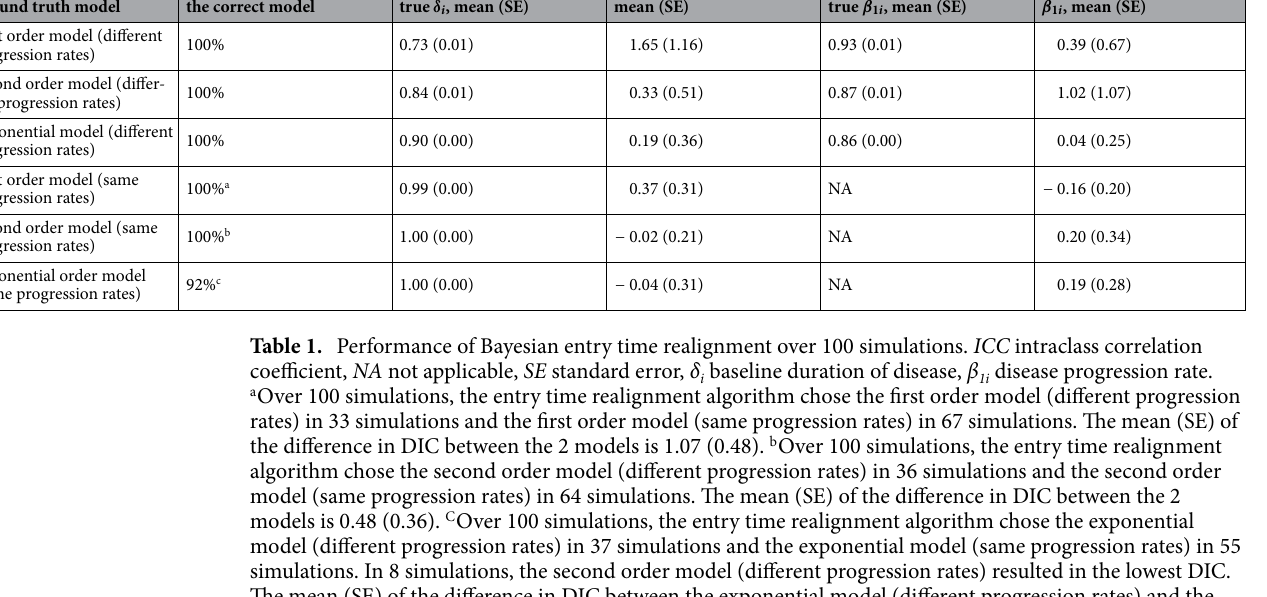
(Table 1), with an average bias ranging from − 0.04 to 0.37% (Table 1). The bias for the estimator of β 1 i ranged from − 0.16 to 0.20 (Table 1). Applying BETR in studying the long‑term natural history of geographic atrophy. We applied BETR to investigate the long-term progression of GA area in 318 eyes from the age-related eye disease study (AREDS). Eyes with GA have well-demarcated atrophic lesions that enlarge progressively over time 25 . The age